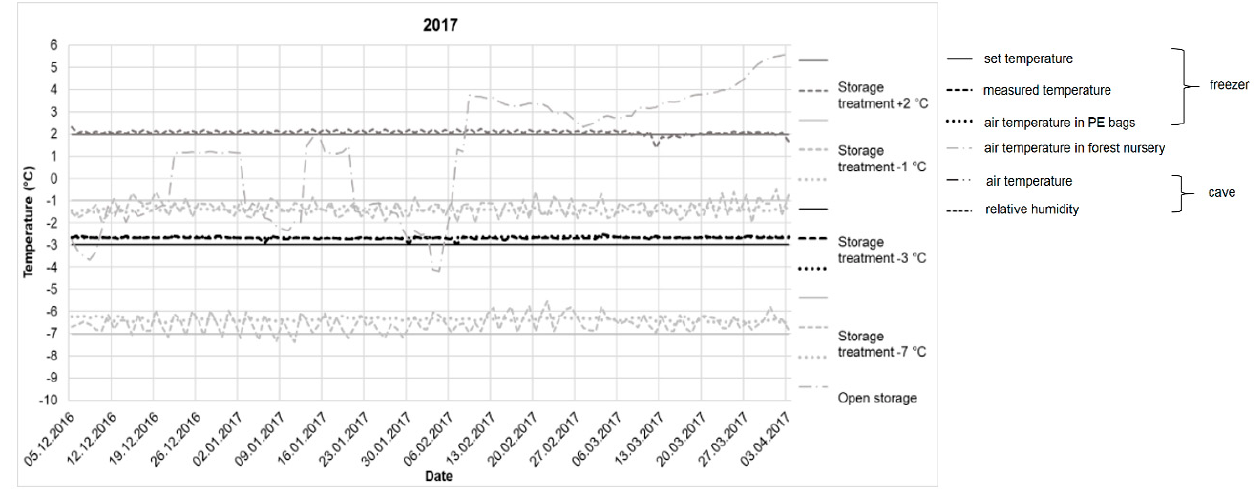
Figure 2. Air temperature during storage of the tested plants in 2017.